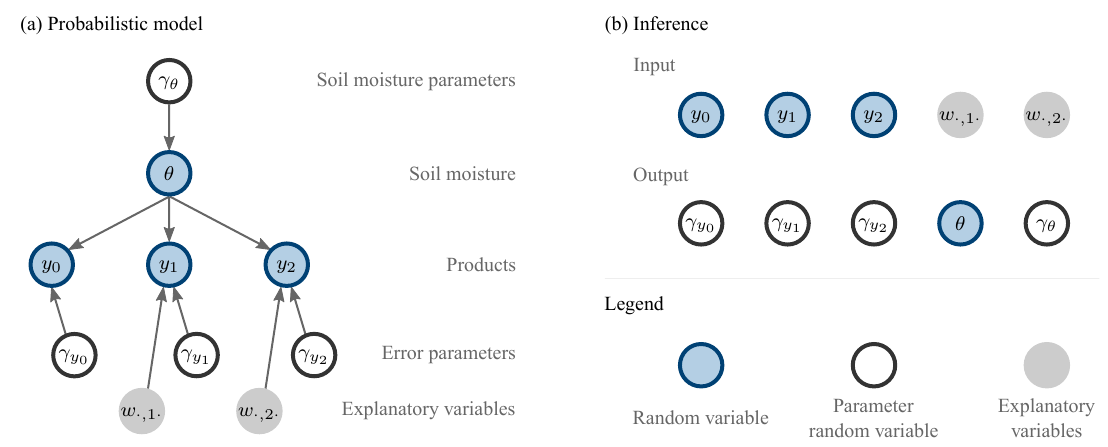
Figure 1. The two components of Bayesian triple collocation. (a) The probabilistic model expresses the observable products in terms of the unknown soil moisture, error parameters and explanatory variables. The set of error parameters of the reference product, γ y contain variable bias terms. (b) The soil moisture products and explanatory variables serve as input to the inference, which produces estimates (posterior probability distributions) of, amongst other things, the error